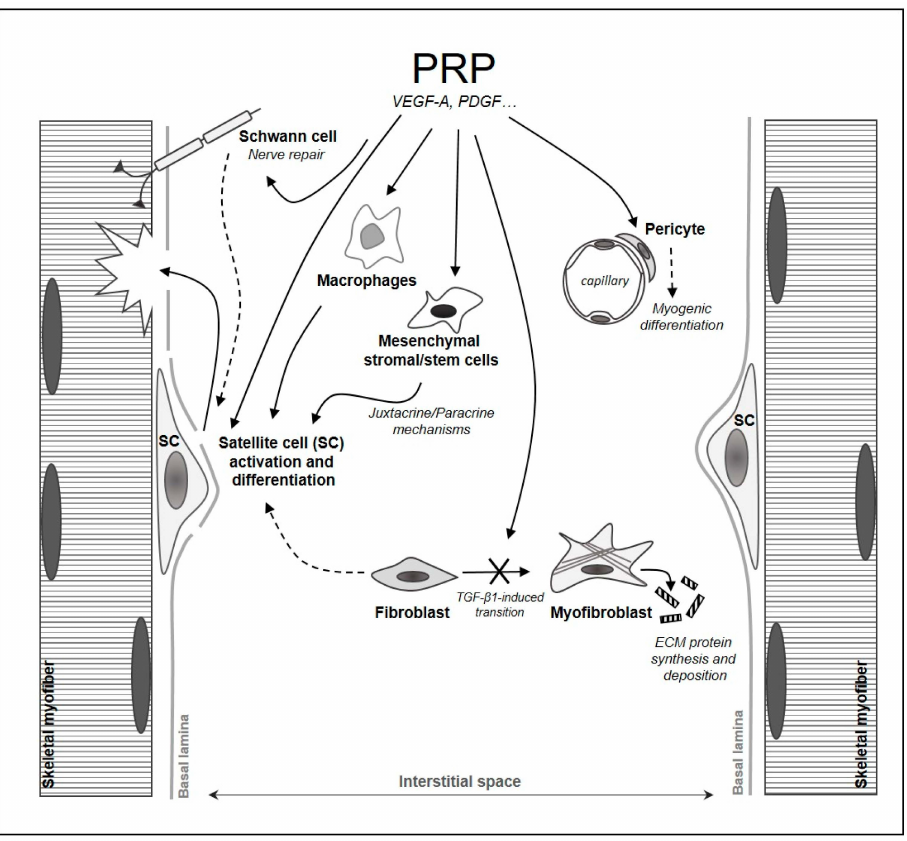
Figure 1. Schematic drawing representing the potential cell targets of PRP during skeletal muscle repair/regeneration, which may mediate its beneficial